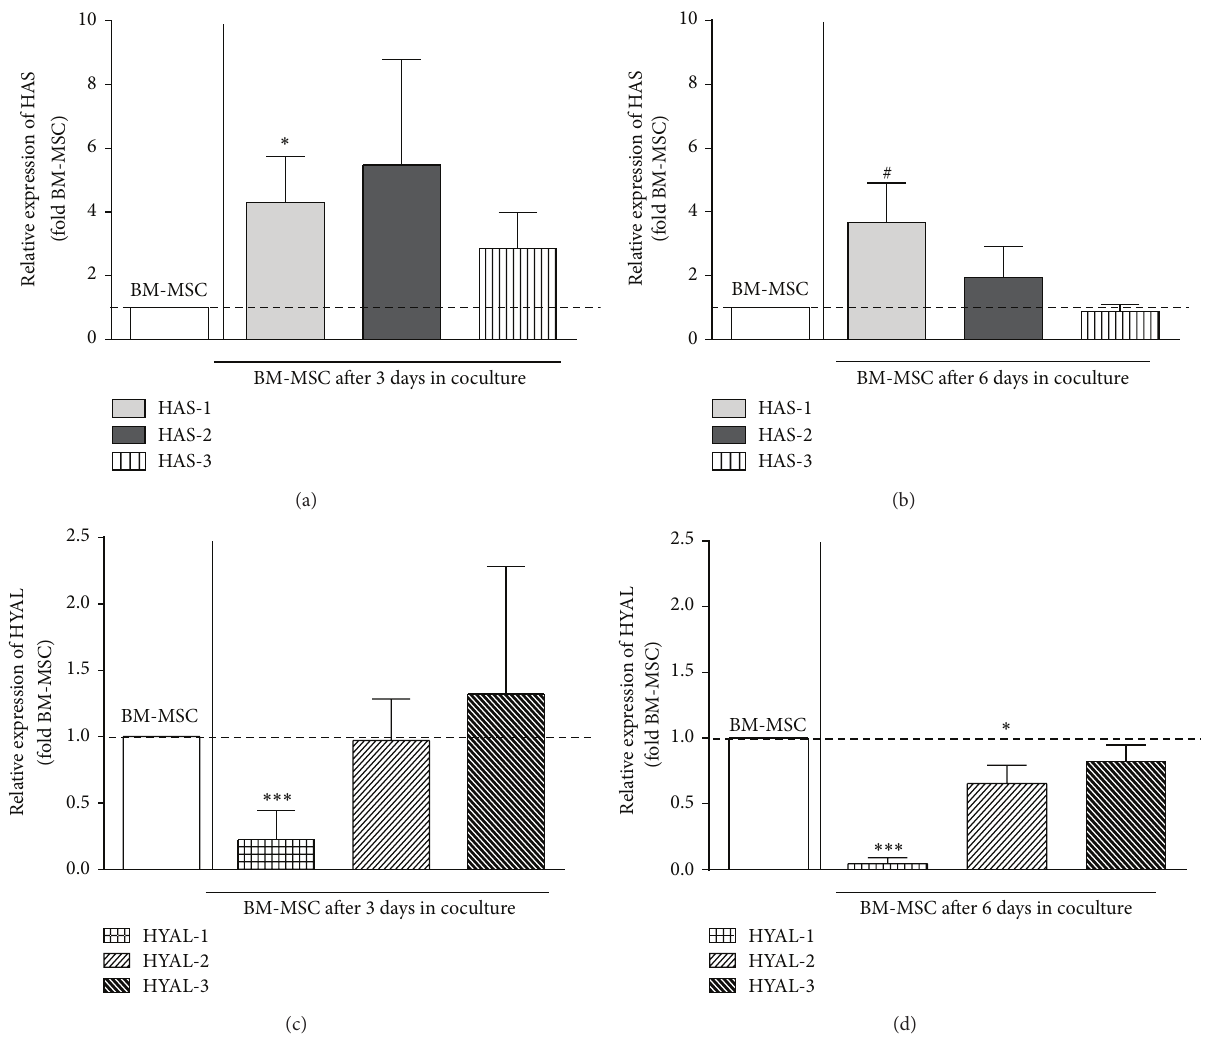
Figure 4: Hyaluronan enzyme mRNA expression in BM-MSC after coculture. mRNA expression of hyaluronan synthase- (HAS-) 1, HAS- 2, and HAS-3 (a-b) and hyaluronidase- (HYAL-) 1, HYAL-2, and HYAL-3 (c-d) after coculture relative to time-matched and cell-matched controls. Expression of HAS in cocultivated BM-MSC relative to BM-MSC monoculture after 3 days (a) and 6 days ( 𝑛 = 5 ) (b); expression of hyaluronidases in cocultivated BM-MSC relative to BM-MSC monoculture after 3 days (c) and 6 days (d) ( 𝑛 = 5 ). Bars represent the mean fold change value ± SEM relative to BM-MSC in monoculture of hyaluronan enzymes. Statistical significance based on unpaired t -test was set according to the number of asterisks, as follows: ∗ 𝑃 ≤ 0.05 , ∗∗ 𝑃 ≤ 0.001